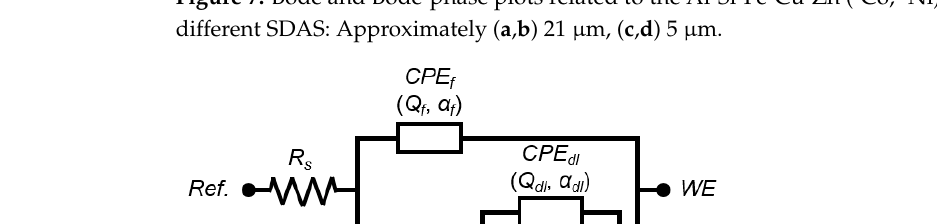
Figure 7. Bode and Bode-phase plots related to the Al-Si-Fe-Cu-Zn (-Co, -Ni) alloy samples having different SDAS: Approximately ( a , b ) 21 μ m, ( c , d ) 5 μ m.